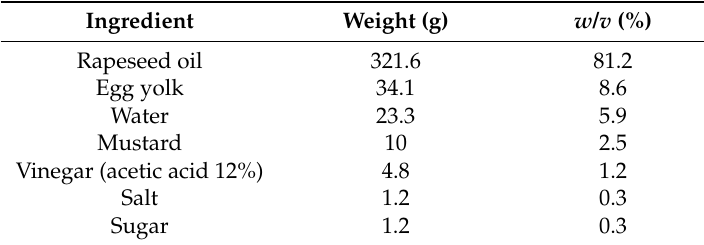
Table 1. List of ingredients in the experimental mayonnaise.